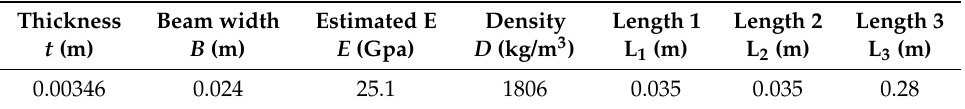
Table 2. Estimated geometric parameters of the beam.